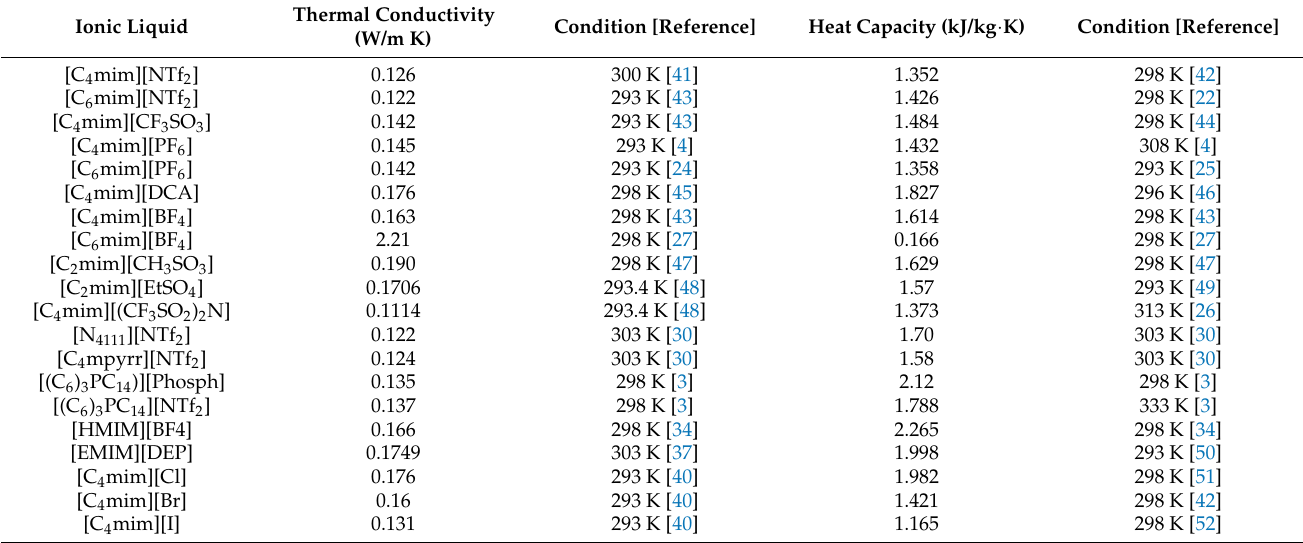
Table 2. Thermal conductivity and heat capacity of ILs used as base fluids for INFs. Ionic